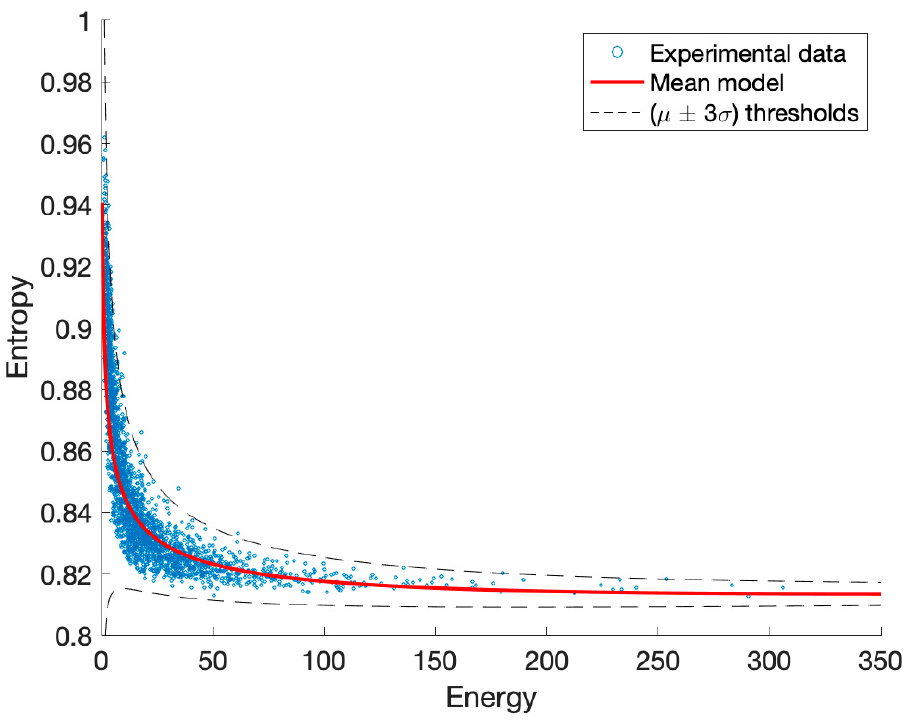
Figure 17. Entropy–energy dispersion and mean model for the Colosseum, from 2011 to 2019. Figure 17. Entropy-energy dispersion and mean model for the Colosseum, from 2011 to 2019.